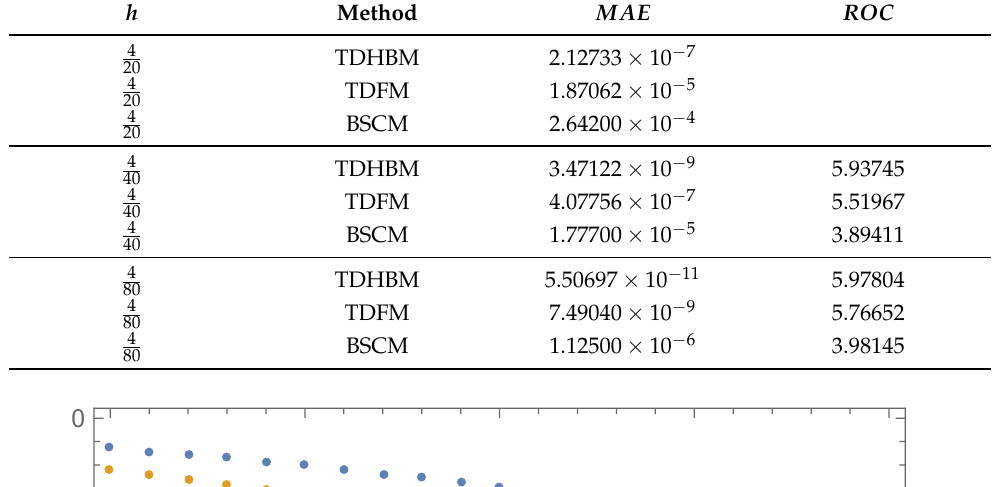
Table 4. Comparison of MAEs and order of convergence for Problem (23).